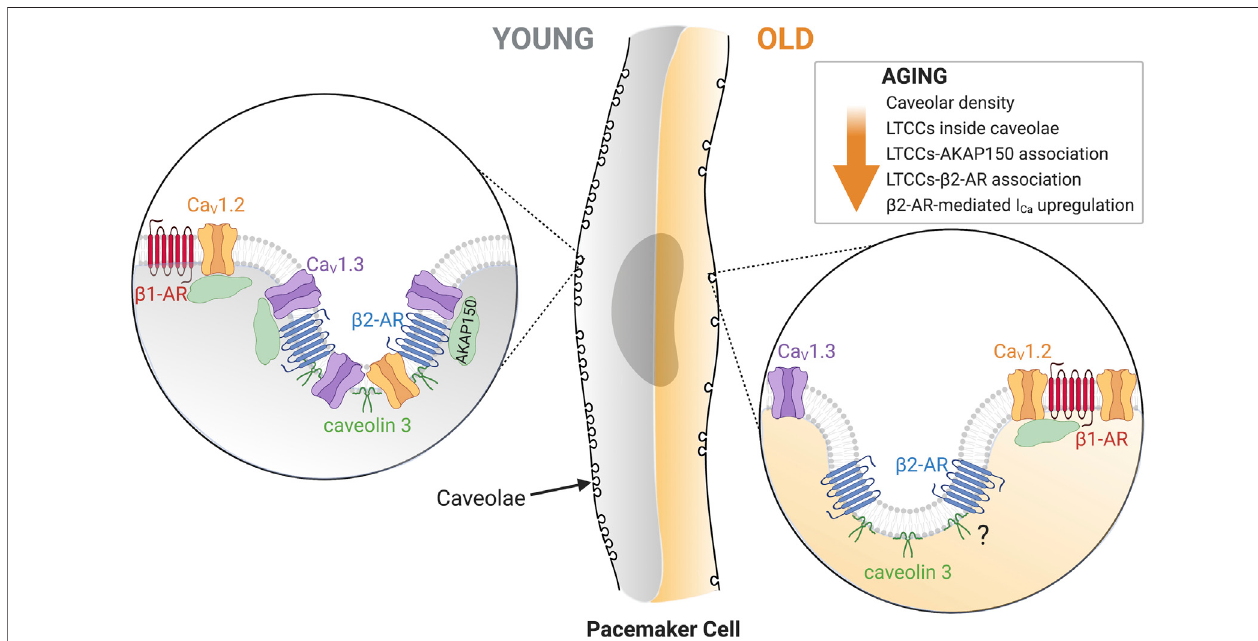
FIGURE 7 | Diagrammatic representation of the main changes in old pacemaker cells that lead to a reduction in L-type calcium current regulation. A global reductionincaveolardensity ischaracteristicofoldcells.Zoomed inontheleftsiderepresent theproposedarchitectural layoutofassociatedproteinsinyoungcells: β 1- AR(red)/Ca V 1.2(orange)outsideofcaveolaeand β 2-AR(blue)/Ca V 1.2(orange)/Ca V 1.3(purple)/Caveolin-3(darkgreen)/AKAP150(lightgreen)insidecaveolae.Zoomed in on the right side shows the proposed architectural changes ofassociated proteins in old cells: β 1-AR (red)/Ca V 1.2 (orange) remain outside caveolae, and β 2-AR (blue)/Caveolin-3 (dark green) remain inside caveolae, while Ca V 1.3 shift outside caveolae. If aging alters the proximity of β 2-AR with caveolin-3 needs future testing. Created with